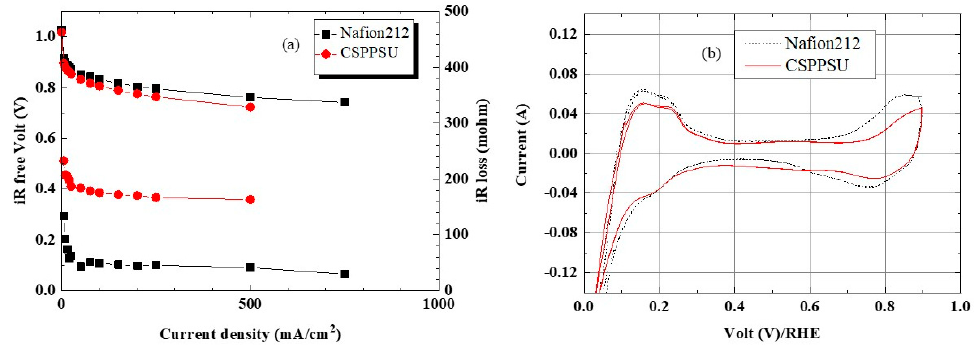
Figure 8. ( a ) I-V iR free and ( b ) CV properties of CSPPSU and Nafion212 membranes at 80 °C and 60% RH. Table 3. I-V and H 2 crossover data for single cells using CSPPSU and Nafion212 membranes. Membrane